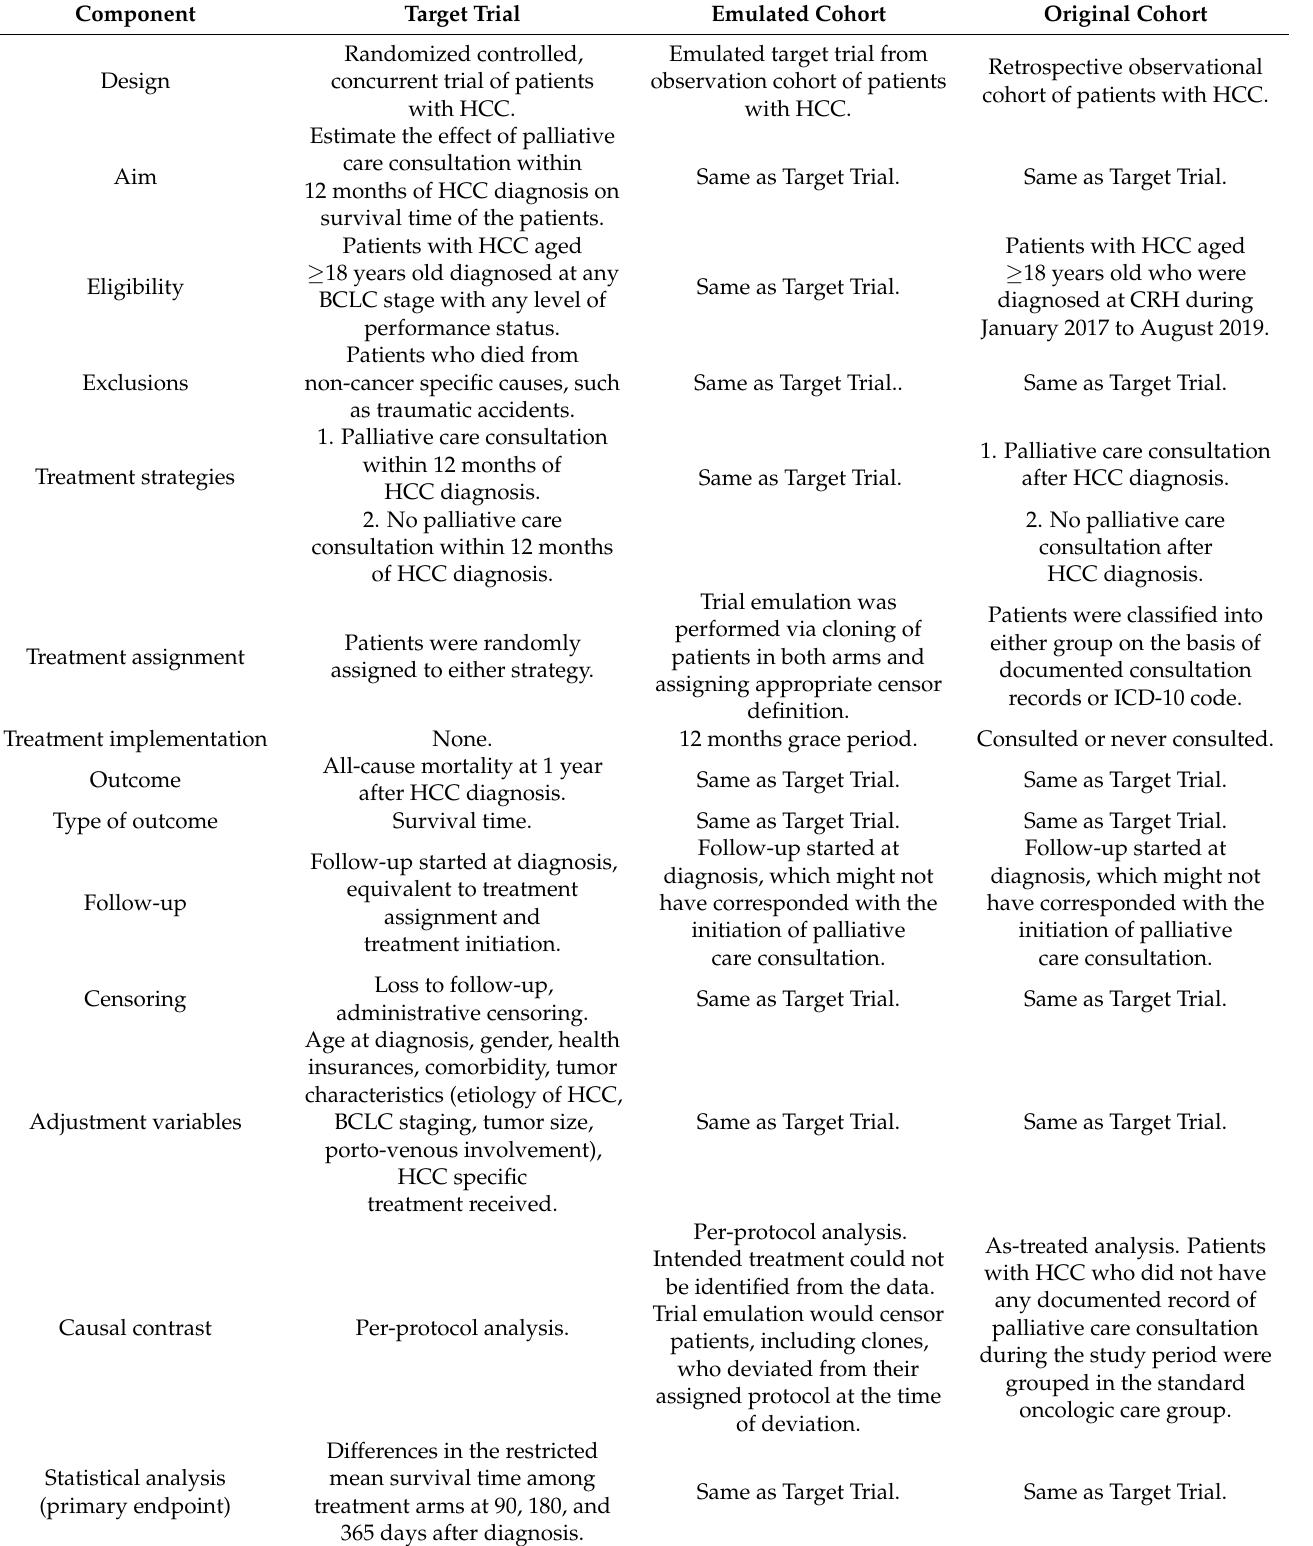
Table 1. Study protocol for target trial emulation comparing to the original patient